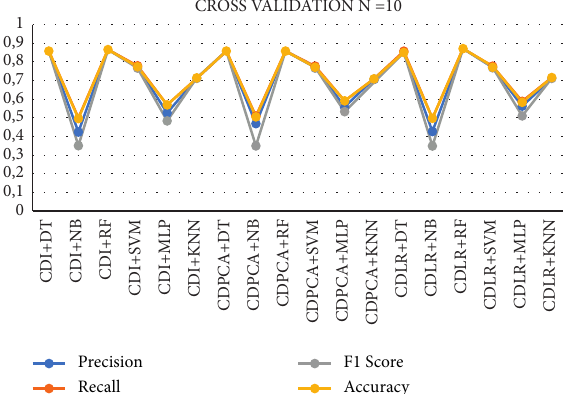
Figure 7: Experimental result of malware Multiclass classification with cross-validation N � 10.